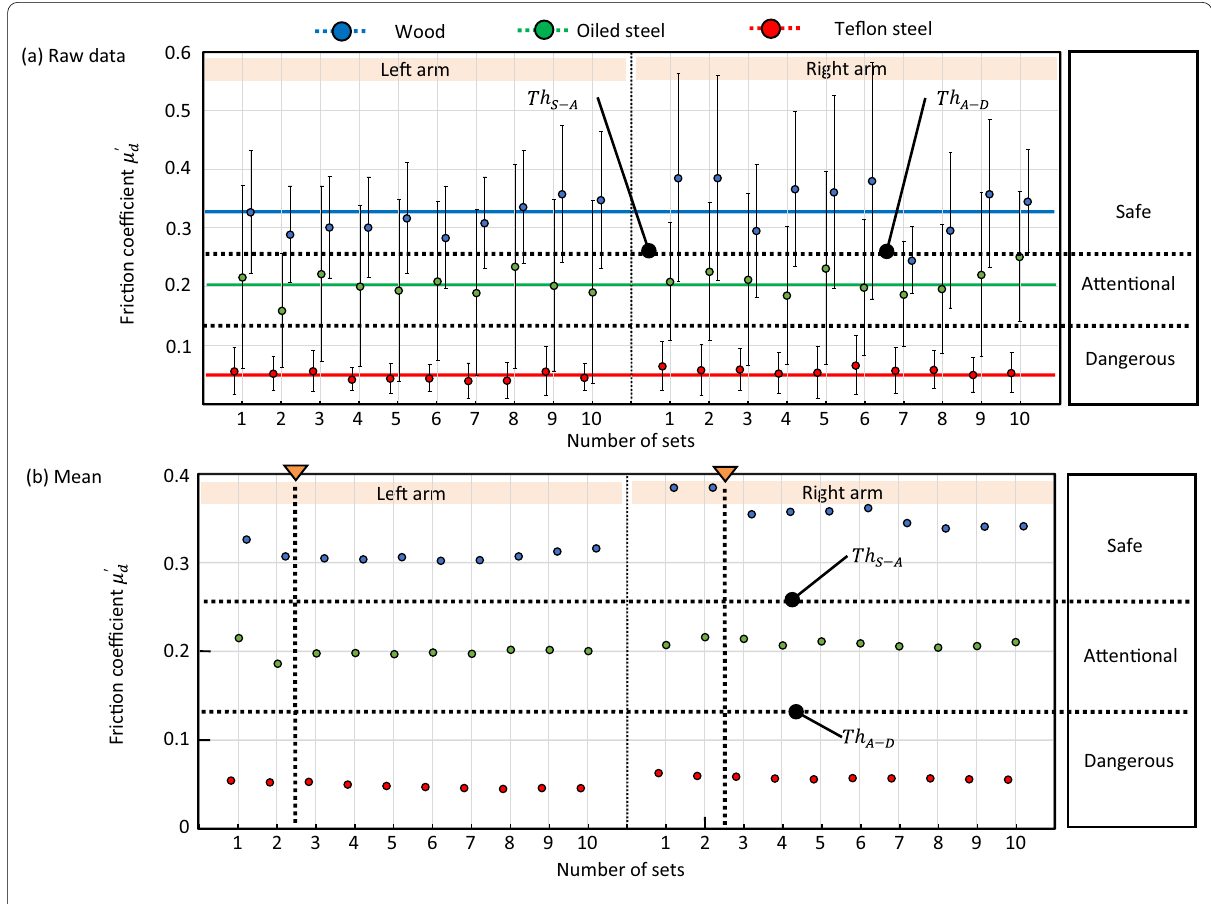
Fig. 10 Estimated friction and accident